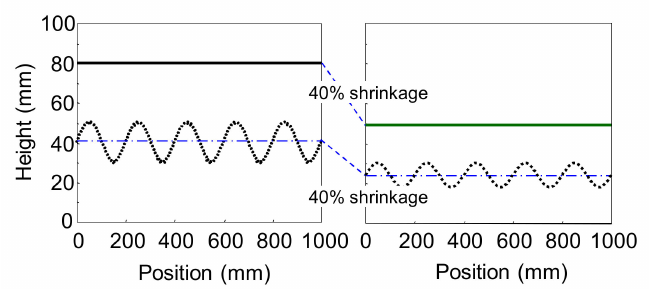
Figure 2. Schematic representation of telegraphing of interface waviness (shrinkage percentage between upper layer and lower layer is